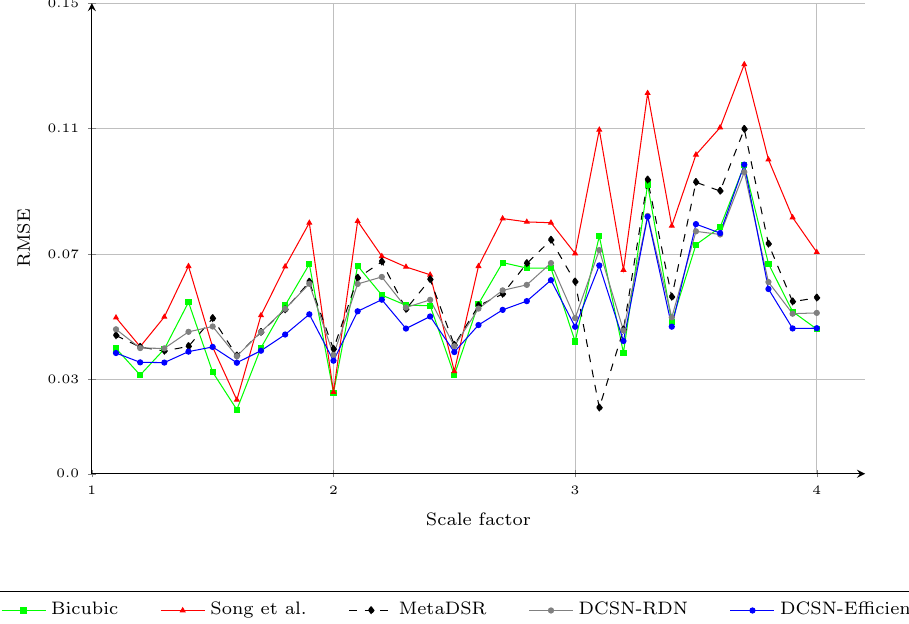
Figure 12. The RMSE of different methods for different upsampling factors [ 1.1,1.2,...,3.9,4.0 ] on the NYUv2 dataset without fine-tuning. We report the results of the modality in [40] trained with arbitrary scale factors, instead of the one that was trained with specific scale factors. Note that the results of the method of Song et al. for noninteger scale factors were obtained by applying bicubic interpolation on the upscaled results of the nearest integer scale